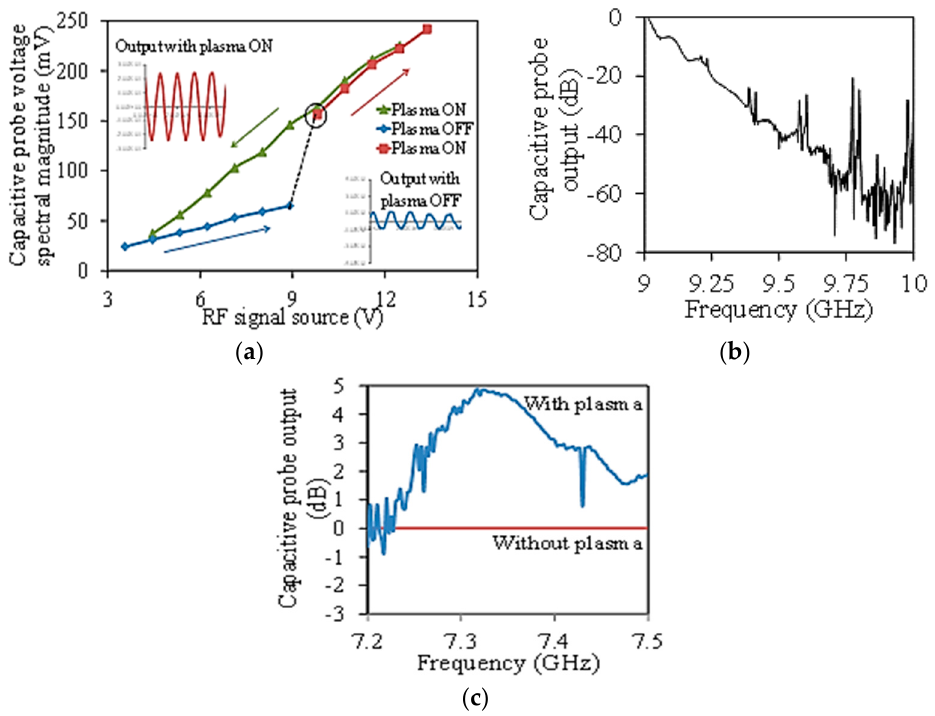
Figure 13. ( a , b ) The switching response of the drain-source current for 937 MHz and 9–10 GHz excitation, respectively. The peaks in (b) indicate plasma generation. This experiment was conducted to test the response of plasma to higher frequencies. The gate electrode was not used in both cases [24]; ( c ) The drain current modulation by gate. The effect is greater around 7.3 GHz due to the lower impedance of the lumped inductor-capacitor (LC) components